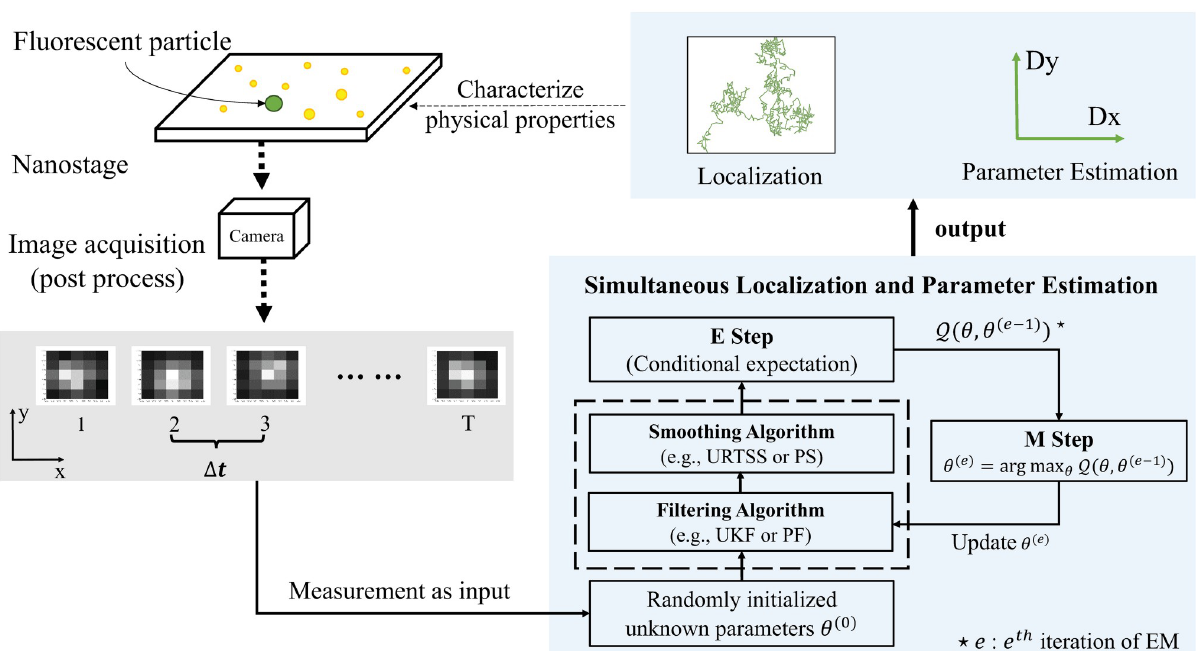
Fig 2. Illustration of the EM-based framework for simultaneous localization and parameter estimation. Segemented image data is passed directly to the estimation routine where EM alternates between filtering/smoothing to find the distribution of the particle trajectory and estimation of the parameter based on that